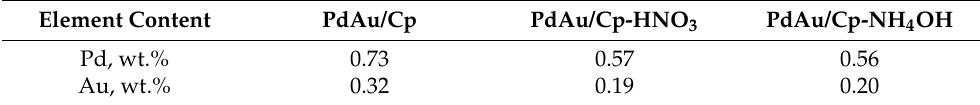
Table 3. Textural properties of catalysts and their corresponding Sibunit supports.